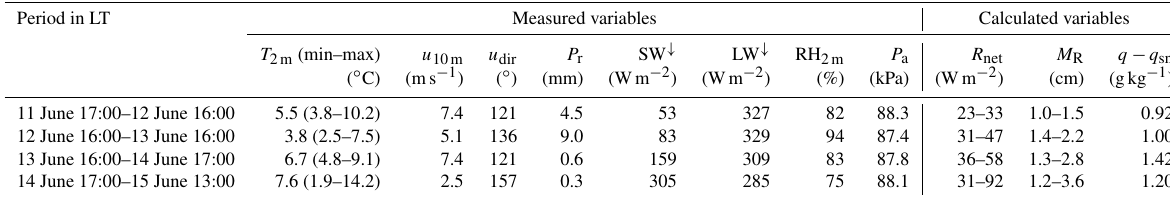
Table 4. Average meteorological measurements and calculated variables in between the photogrammetry observations. T 2m is the air temper- ature measured at 2m; u 10m and u dir are, respectively, the wind speed and wind direction in degrees from the north and measured at 10m; P r is the summed precipitation during the period; SW ↓ and LW ↓ are, respectively, the incoming shortwave and longwave radiation; RH 2m is the measured relative humidity at 2m; and P a is the air pressure. The net radiation ( R net ), subsequent melt ( M R ), and specific humidity difference ( q − q sn ) were computed based on a combination of the measured variables. The ranges for R net and M R are caused by applying two values for the albedo, i.e., 0.6 and 0.8, to account for uncertainties in the shortwave radiation component (see Sect. 2). Period in LT Measured variables Calculated variables T 2m